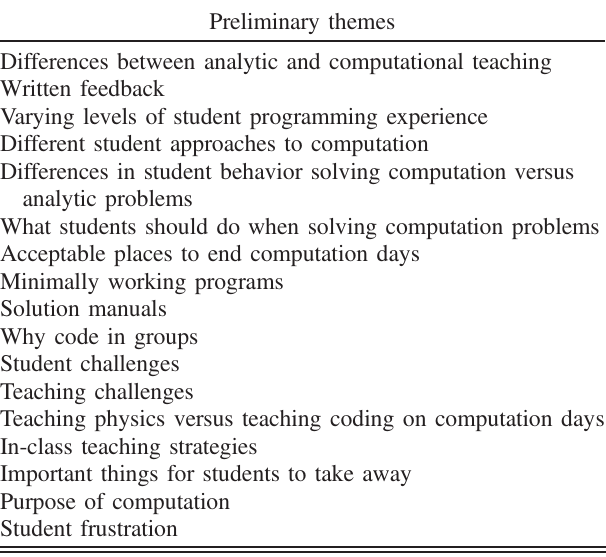
TABLE V. List of preliminary emergent themes identified in the data.